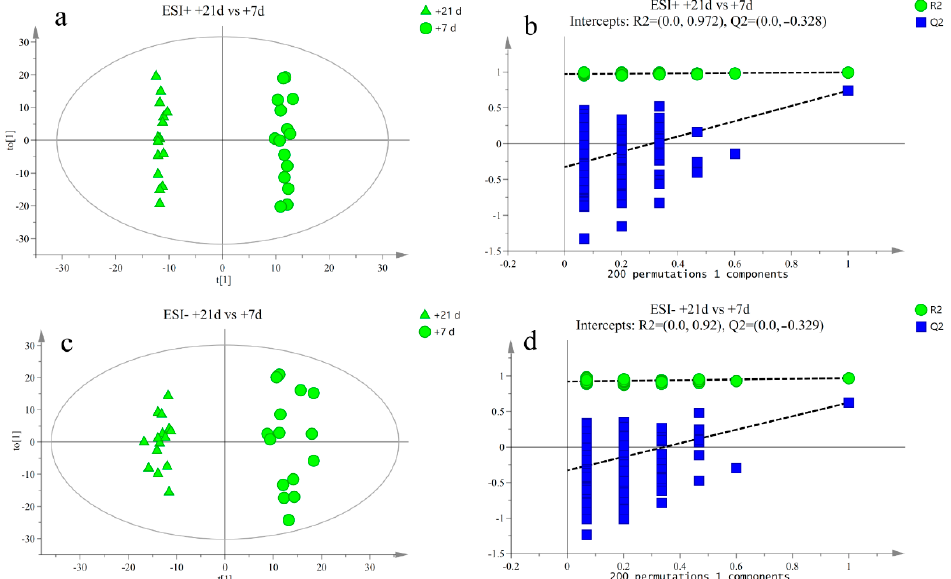
Figure 6. ( a , b ) Orthogonal partial least squares discriminant analysis (OPLS-DA) of scores and permutation test plots for the +21 d and +7 d group samples analyzed in the positive ion mode, respectively. ( c , d ) Orthogonal partial least squares discriminant analysis of scores and permutation test plots for the +21 d and +7 d group samples analyzed in the negative ion mode, respectively. t[1]—first principal component; to [1]—second orthogonal component. The intercept limit of Q 2 , calcu- lated by regression line, is the plot of Q 2 from permutation test in the OPLS-DA model.